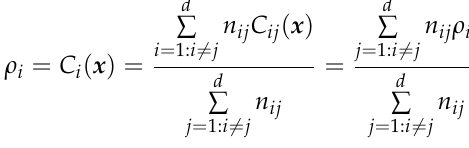
Figure 2. Comparisons between one versus all and one versus one strategy.